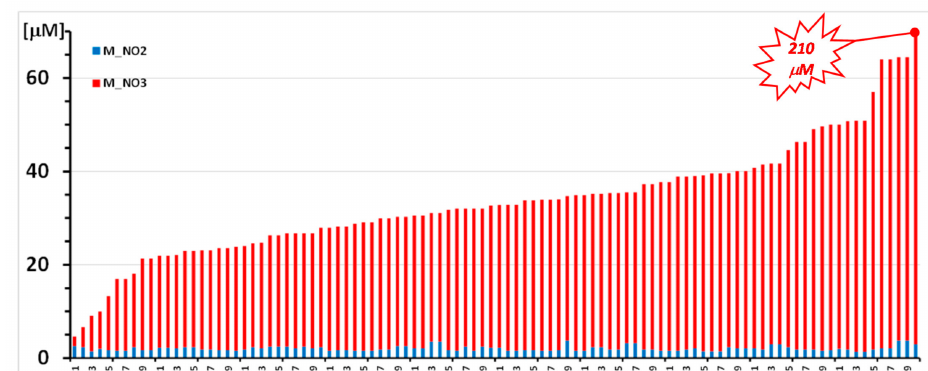
Figure 6. Nitrite (blue bar) and nitrate (red bar) concentrations were measured in 100 plasma samples from 11 anonymized scuba divers who participated in a training session at three progressively deeper water levels in a land facility. The concentration of both analytes is reported as µ moles/L. No sample yielded nitrite concentration < LoD. Sample 100 reached a nitrate concentration of 210 µ M (sample 2 of Figure